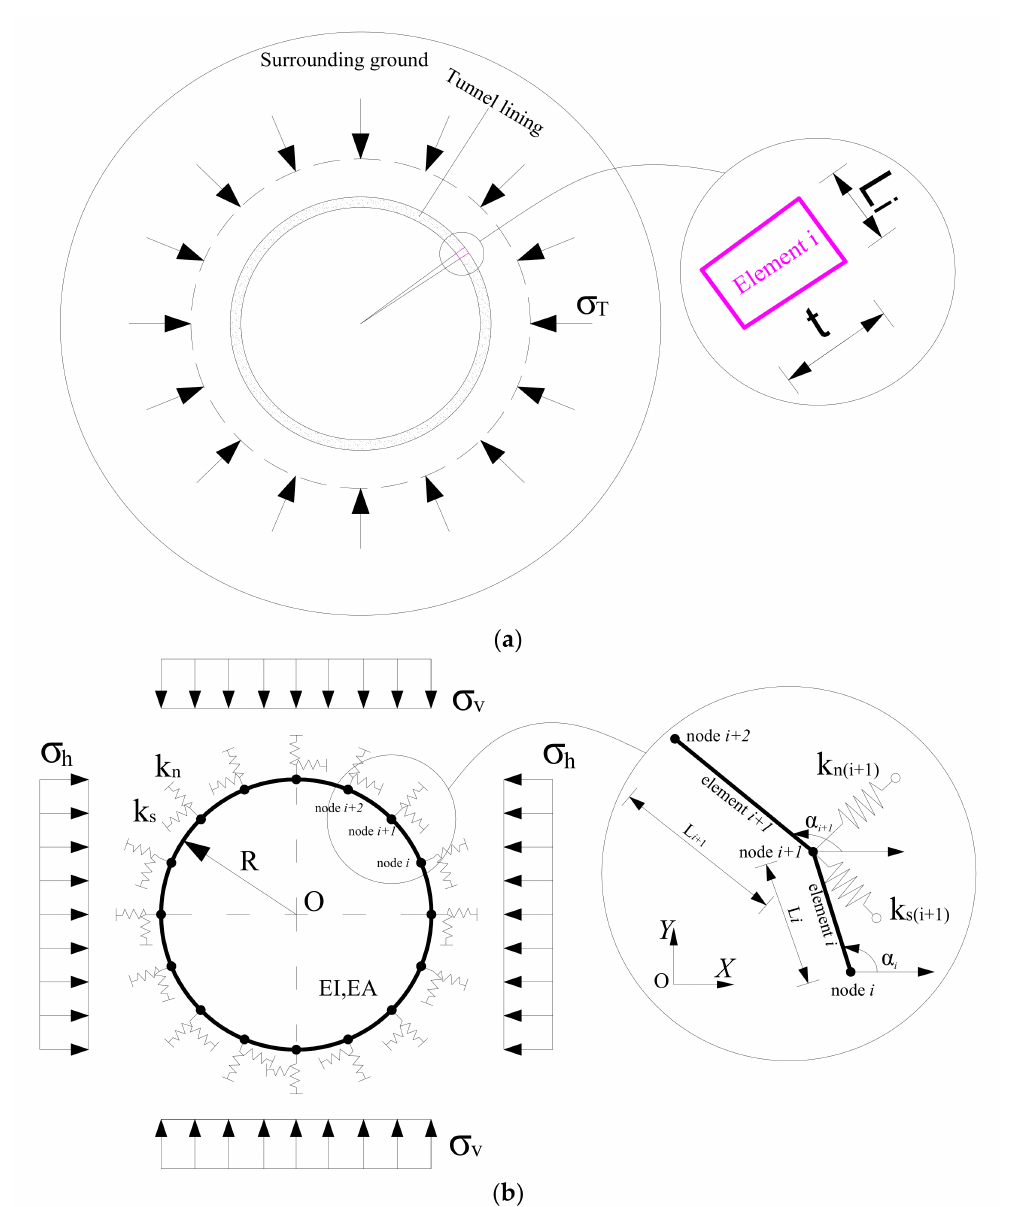
Figure 1. Schematic diagram of circular tunnel lining in the analysis: ( a ) Calculation sketch of the additional thermal loads caused by temperature change; ( b ) Circular support structures in the HRM